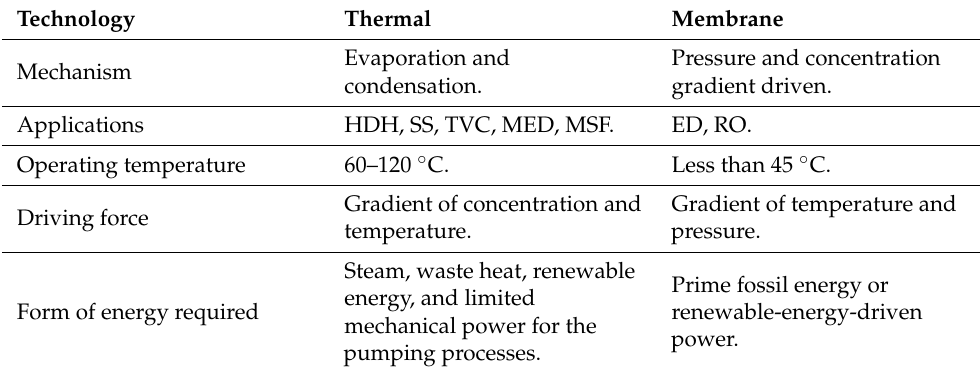
Table 1. Descriptions of thermal and membrane WD